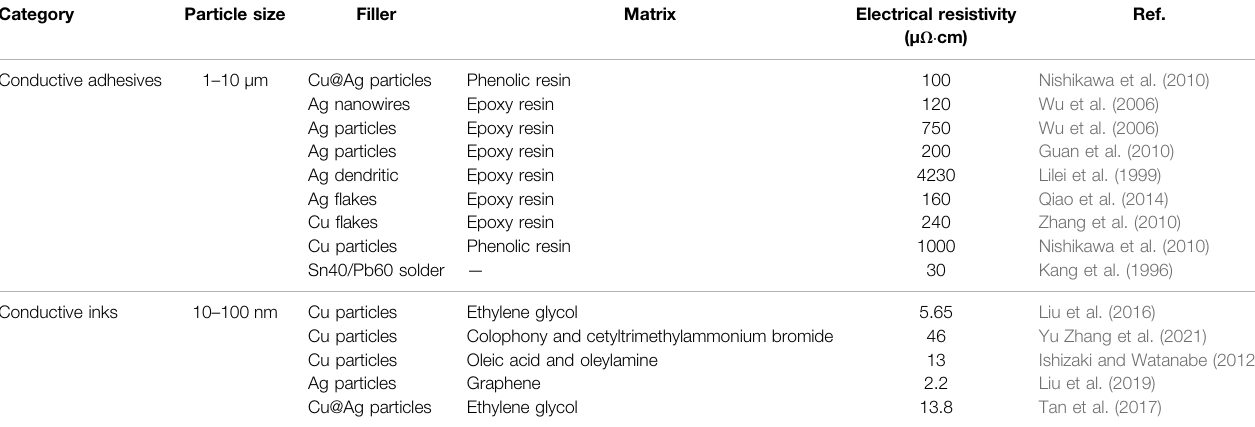
TABLE 1 | Summary of some reported conductive